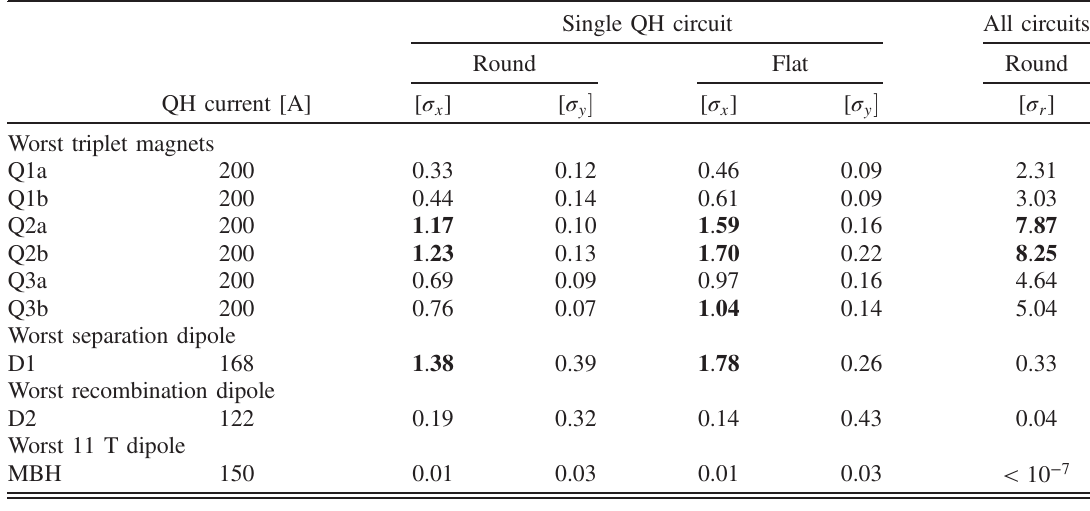
TABLE II. QH results: kick strength of worst case single QH circuits as well as nominal firing of all circuits. Each triplet quadrupole is split in equal halves, designated by a and b, with a being closer to the IP. Single QH circuit All circuits Round Flat